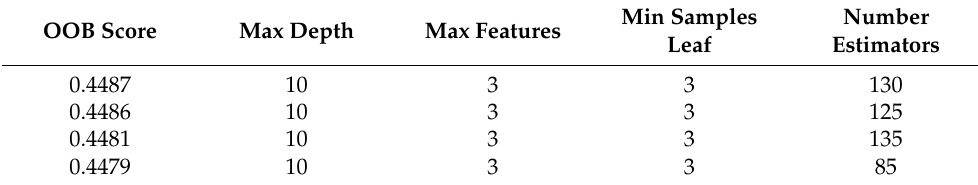
Table 5. Adjusted parameters and OOB